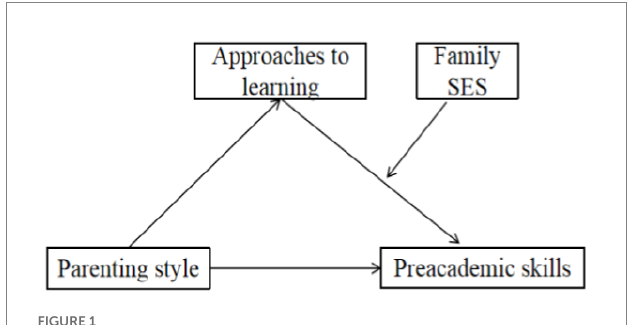
FIGURE 1 The moderated mediation